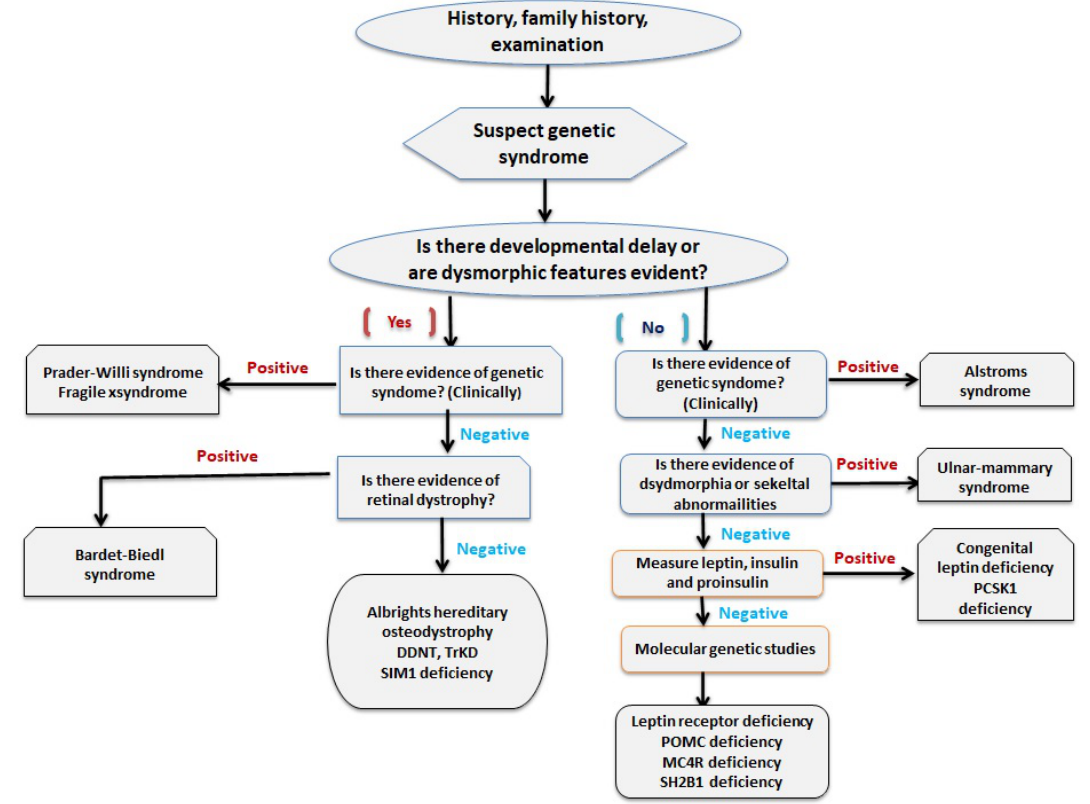
Figure 2. A flowchart showing the approach to diagnosing syndromic obesity [32]. Abbreviations: BDNF, brain derived neurotrophic factor; MC4R, melanocortin-4 receptor; POMC, proopiomelanocortin; SIM1, single-minded homolog 1; TrKB, tyrosine kinase B.